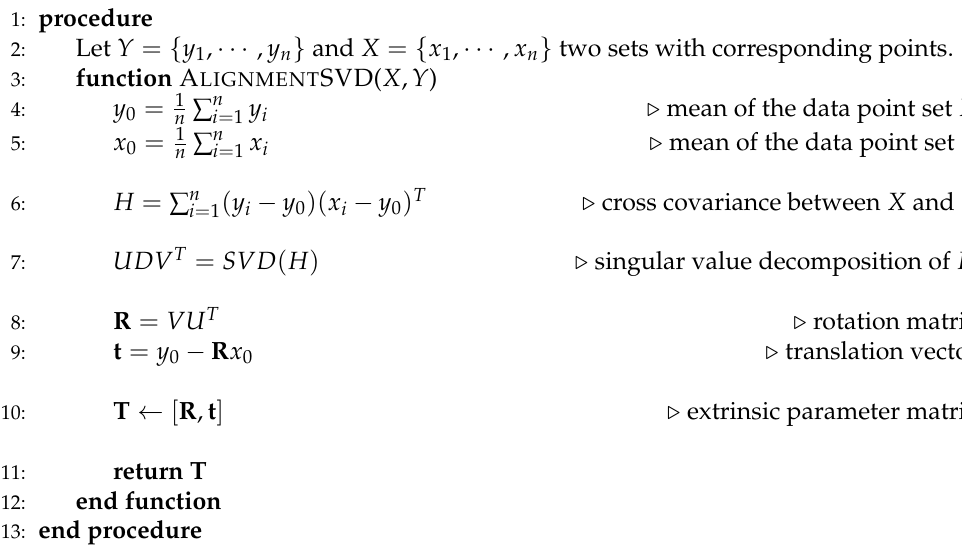
Algorithm 2 Least squares alignment of two 3D point sets based on